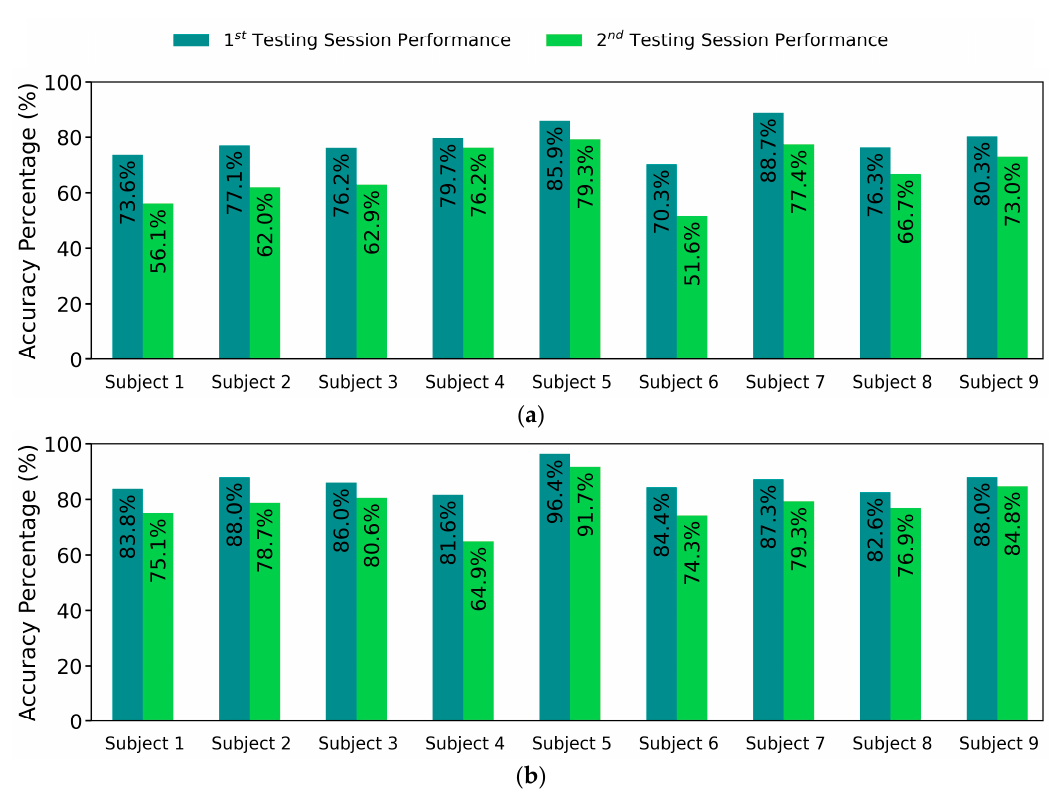
Figure 7. Comparison of QDA accuracy using raw and pipeline feature spaces per test session of each participant. ( a ) QDA accuracy results on raw features. ( b ) QDA accuracy results on the pipeline features.